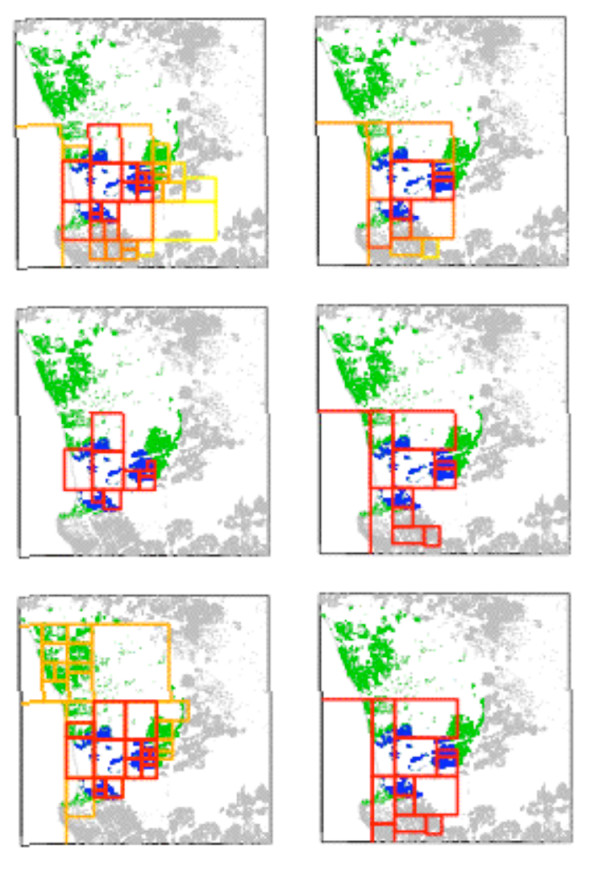
RC A: Qualifying LACT results. Rows, from the top, represent the LACTs (Episcan, FleXScan, and SaTScan areal) and columns, from the left, represent the areal unit sets (Set 1 (maximum unit pop. = 1000), Set 2 (maximum unit pop. = 2000). The underlying green and blue points indicate the qualifying SaTScan point clusters. All other located births are gray points. On Row 1, the Episcan display uses a heat map to indicate the most likely cluster area within reported significant clusters. In Row 3, Column1, SaTScan areal Set 1 had two overlapping significant clusters, both shown here in different colors.